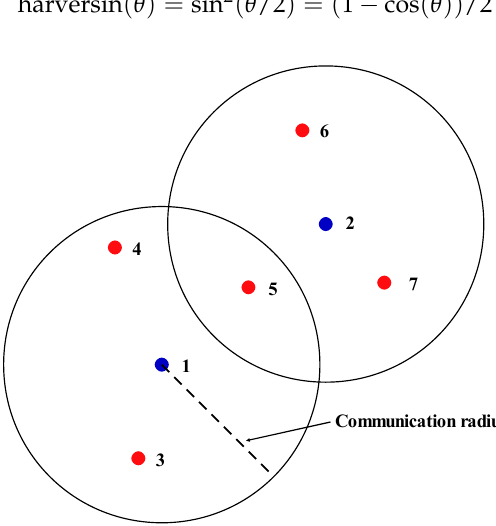
Figure 5. Schematic of neighbor nodes. The neighbor nodes of node 1 were node 3, node 4, and node 5. The neighbor nodes of node 2 were node 5, node 6, and node 7.